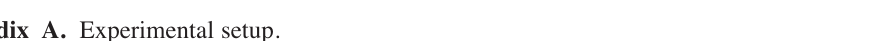
Table A.I. Starting compositions (wt%).